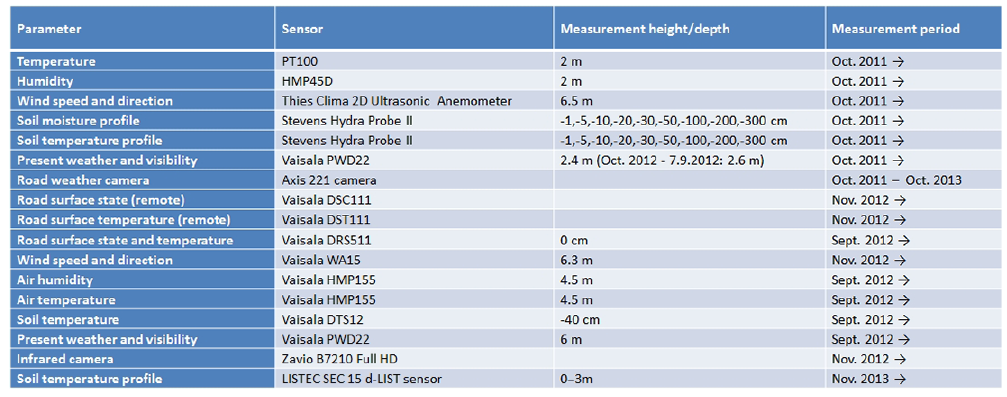
Figure 2. Collection of RWS measurements.